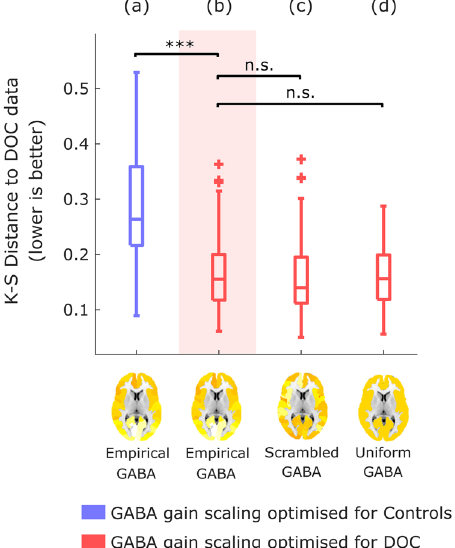
Fig. 5 Modulation of inhibitory gain by empirical GABA-A receptor density improves model fi t to DOC brain dynamics. Box-plots show the KS-distance (lower is better) to the empirical brain activity of DOC patients, for n = 100 simulations of a model that ( a ) is informed by empirical GABA-A regional density, using the value of gain for inhibitory scaling s I derived from calibrating the model with respect to healthy controls ’ empirical brain activity (blue); ( b ) is informed by empirical GABA- A regional density, using the value of gain for inhibitory scaling s I that provides the best fi t to the DOC patients ’ empirical brain activity (red); ( c ) same as ( b ), but the regional receptor densities are randomly reshuf fl ed across the cortex; ( d ) same as ( b ), but the receptor densities are all set to a uniform value (the mean of the empirical distribution). Middle line: median; box limits, upper and lower quartiles; whiskers, 1.5x inter-quartile range; “ + ” symbol indicates outliers; *** p < 0.001. n.s. Not signi fi cant ( p > 0.05) from t-test. Source data are provided in Supplementary Data 3.